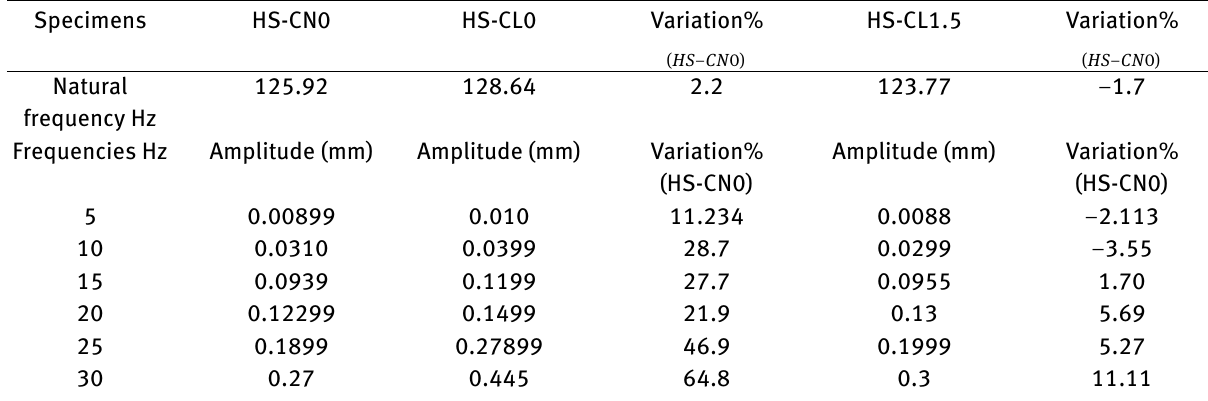
Table 5: Maximum amplitude for the specimens under harmonic load Specimens Natural